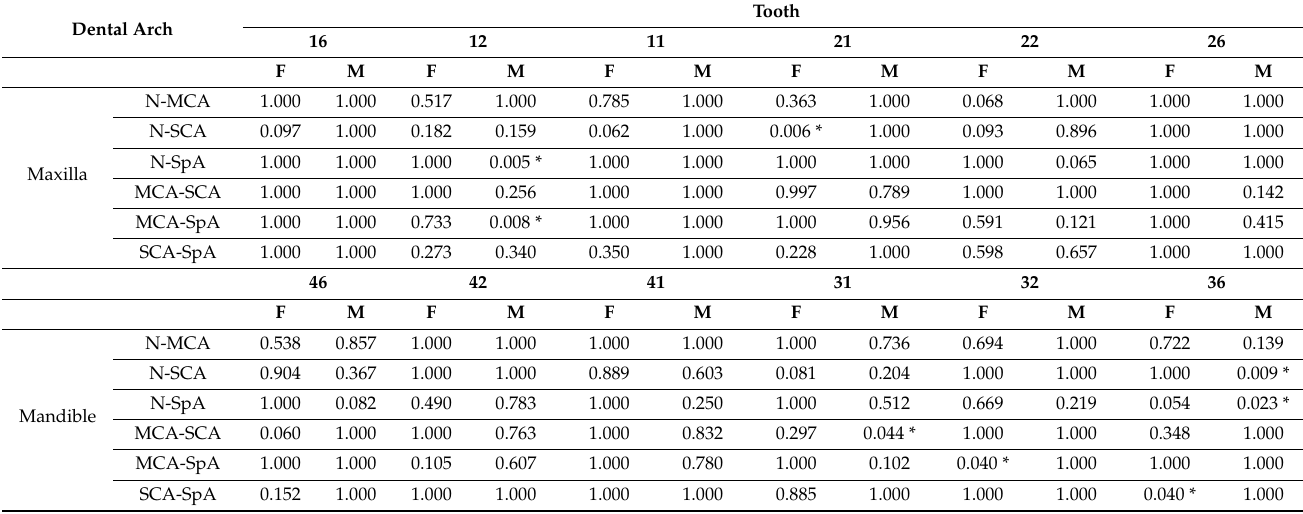
Table 8. Results of the post hoc Bonferroni test ( p values of subgroup comparisons) aimed at comparing the BL dimensions of teeth between the four groups for female and male